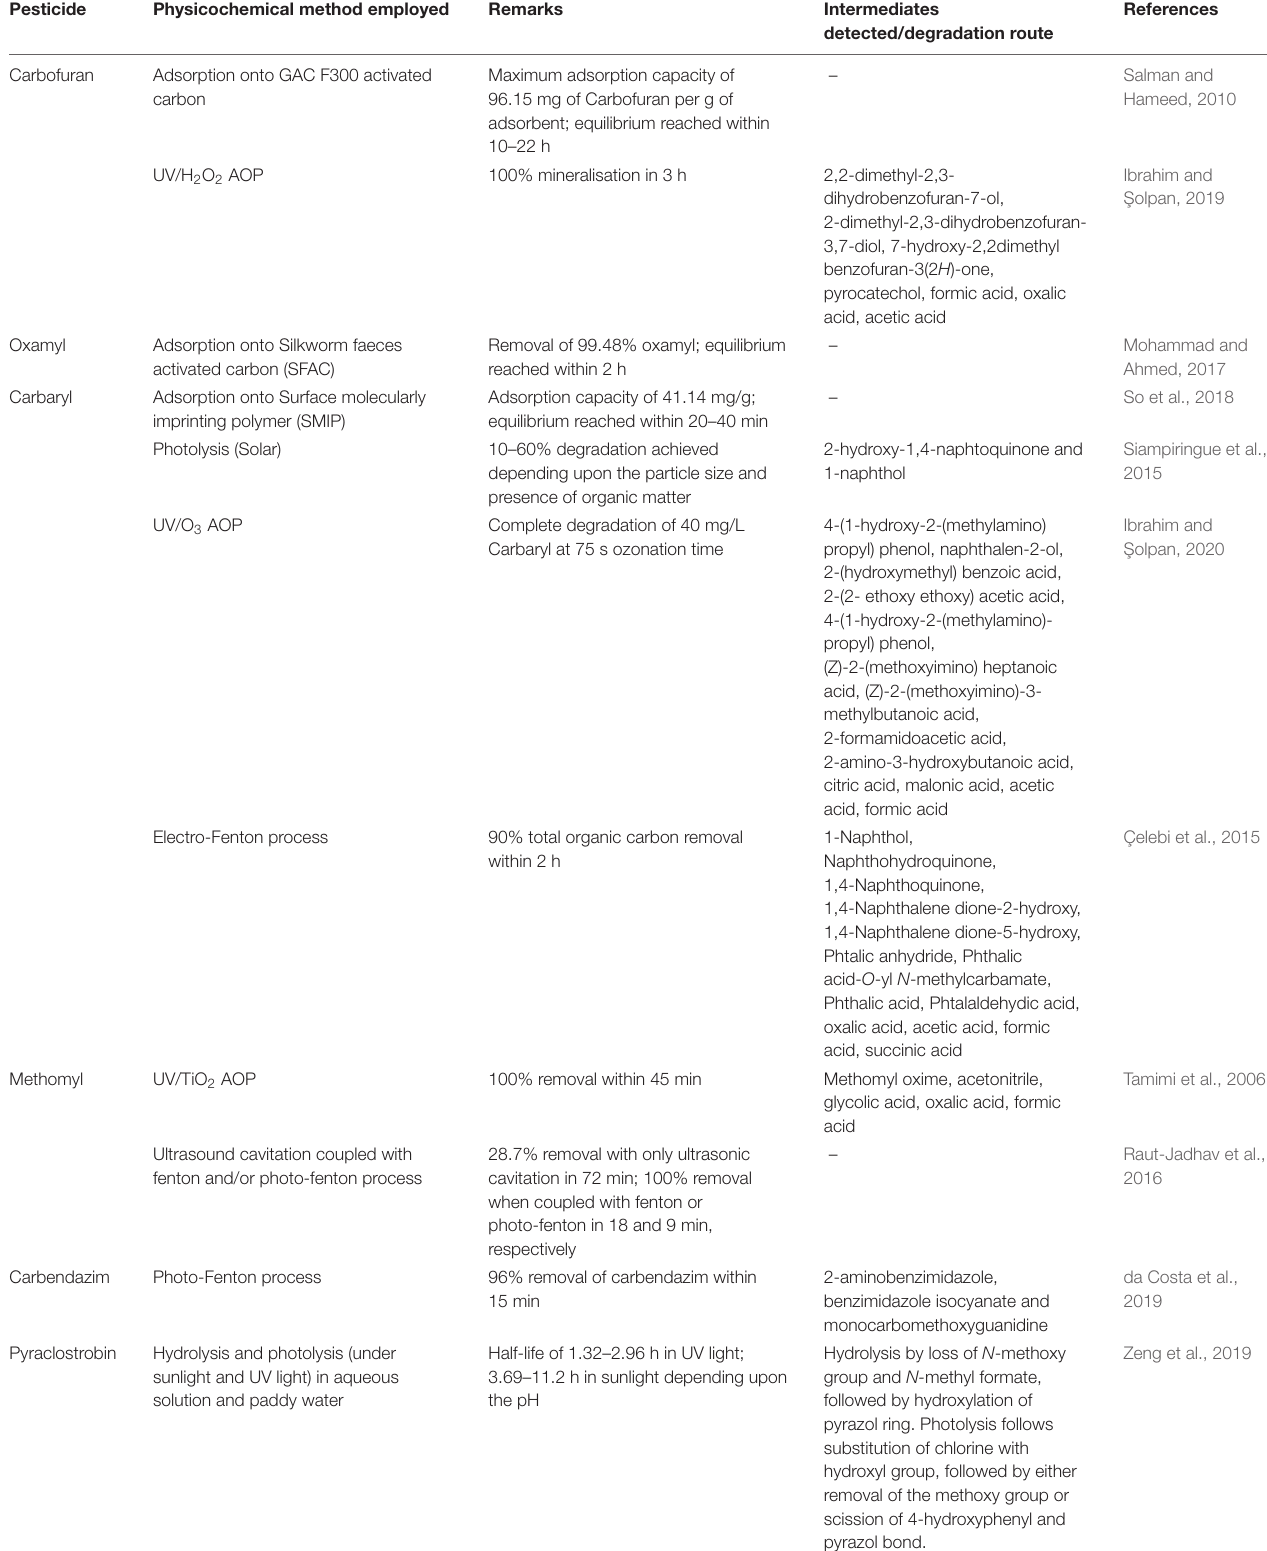
TABLE 3 | Physico-chemical methods employed in the remediation of